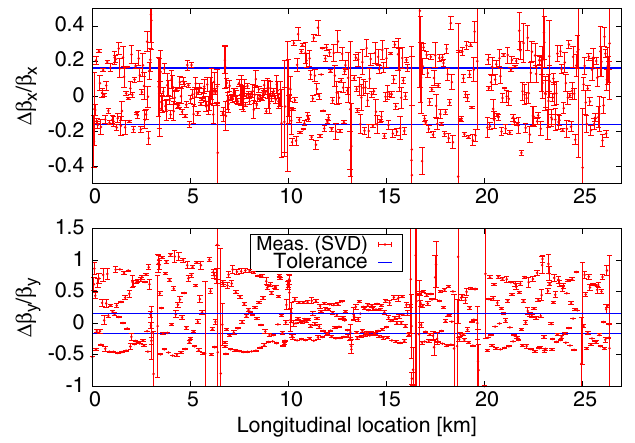
FIG. 4. (Color) Measured horizontal (top) and vertical (bottom) beta beating versus longitudinal location together with toleran- ces.